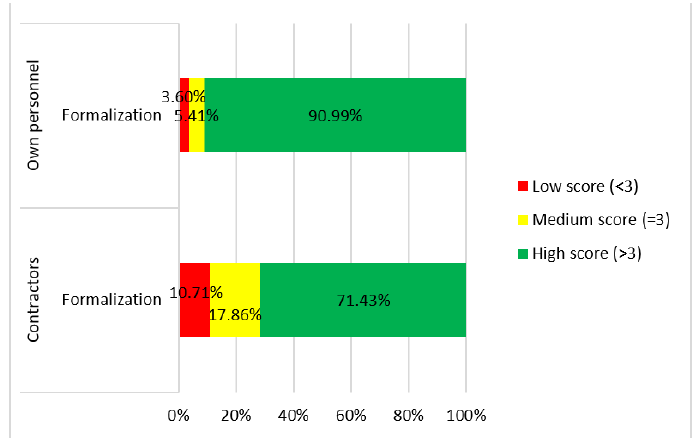
Figure 16. Categorized BARS percentages for attention to safety, by contractual relationship.